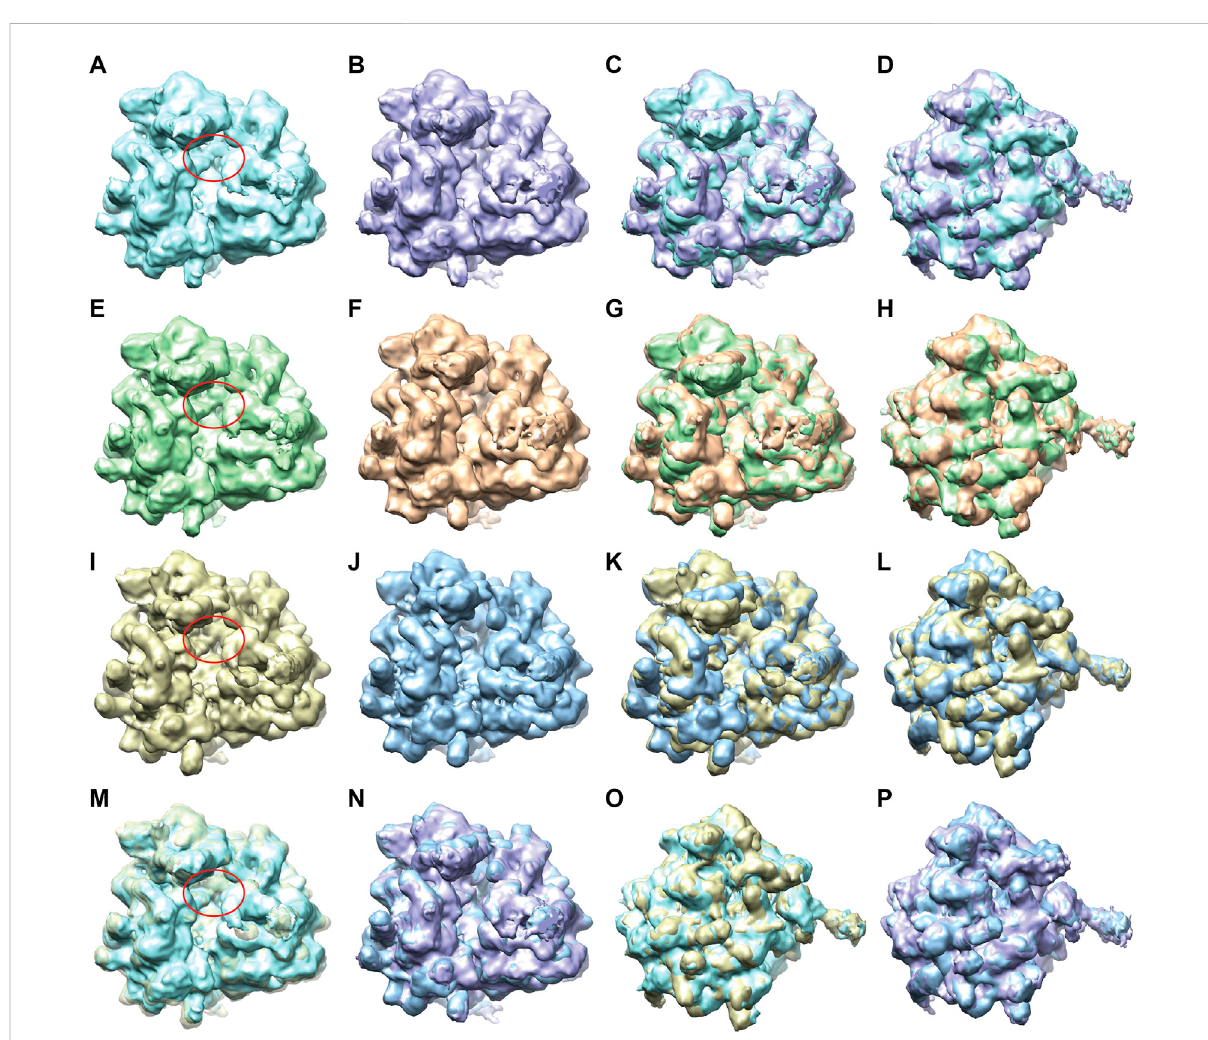
FIGURE 8 Two average conformations of yeast 80S ribosome-tRNA complexes obtained by 3D reconstruction from EMPIAR-10016 cryo-EM images, with and without additional mass in the region marked with a red ellipse, using DeepHEMNMA and using the original FREALIGN classi fi cation parameters from EMPIAR-10016 dataset. (A,B) Same view of two reconstructions obtained from the conformational space based on 12,095 images withinferredparameters(SupplementaryFigureS4),fromwhichgroupsof4,741and4,219imageswereusedforthereconstructions. (C,D) Two views of the superposed reconstructions from A and B. (E,F) Same view of two reconstructions obtained from the conformational space based on 12,095 images with inferred parameters and 10,000 images with HEMNMA-estimated parameters (Supplementary Figure S5), from which groups of 7,870 and 6,682 images were used for the reconstructions. (G,H) Two views of the superposed reconstructions from E and F. (I,J) Same view of two reconstructions obtained using FREALIGN parameters for 22,369 and 23,726 images resulting in EMD-5977 and EMD-5976 maps, respectively. (K,L) Two views of the superposed reconstructions from I and J. ( M,N) Superposition of the reconstructions obtained from images with inferred parameters and those obtained using FREALIGN parameters (M: overlap between the reconstructions shown in A and I; N: overlap between the reconstructionsshowninBandJ). (O,P) DifferentviewofthesuperposedvolumesshowninM-N,respectively.TheredellipseshowninpanelsA,E,I, M indicates the region with the additional mass (corresponding to the additional tRNA), with respect to the same region in panels B, F, J, N, respectively. All surfaces are shown in solid color except for the yellow surface in M that is shown transparent for a better visualization of the additional mass (red